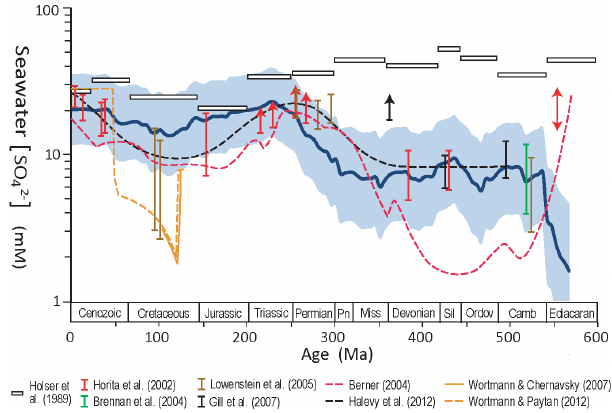
Figure 5. Comparison of Phanerozoic seawater sulfate [SO 2 − records. The mean trend of the present study is shown by a thick blue line, with the ± 1 σ uncertainty range shown as a blue band. Estimates are based either on fluid-inclusion studies (Horita et al., 2002; Brennan et al., 2004; Lowenstein et al., 2005) or C–S-cycle modeling (Holser et al., 1989; Berner, 2004; Gill et al., 2007; Wort- mann and Chernyavsky, 2007; Wortmann and Paytan, 2012; Halevy et al., 2012). Arrows indicate unconstrained minimum or maximum